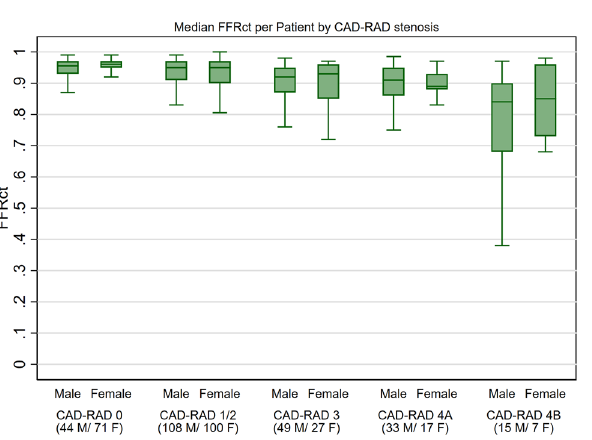
Figure 1. Median FFR CT per patient and for each coronary vessel stratified by sex and CAD-RAD score. FFR CT Fractional flow reserve derived using computed tomography, M male, F